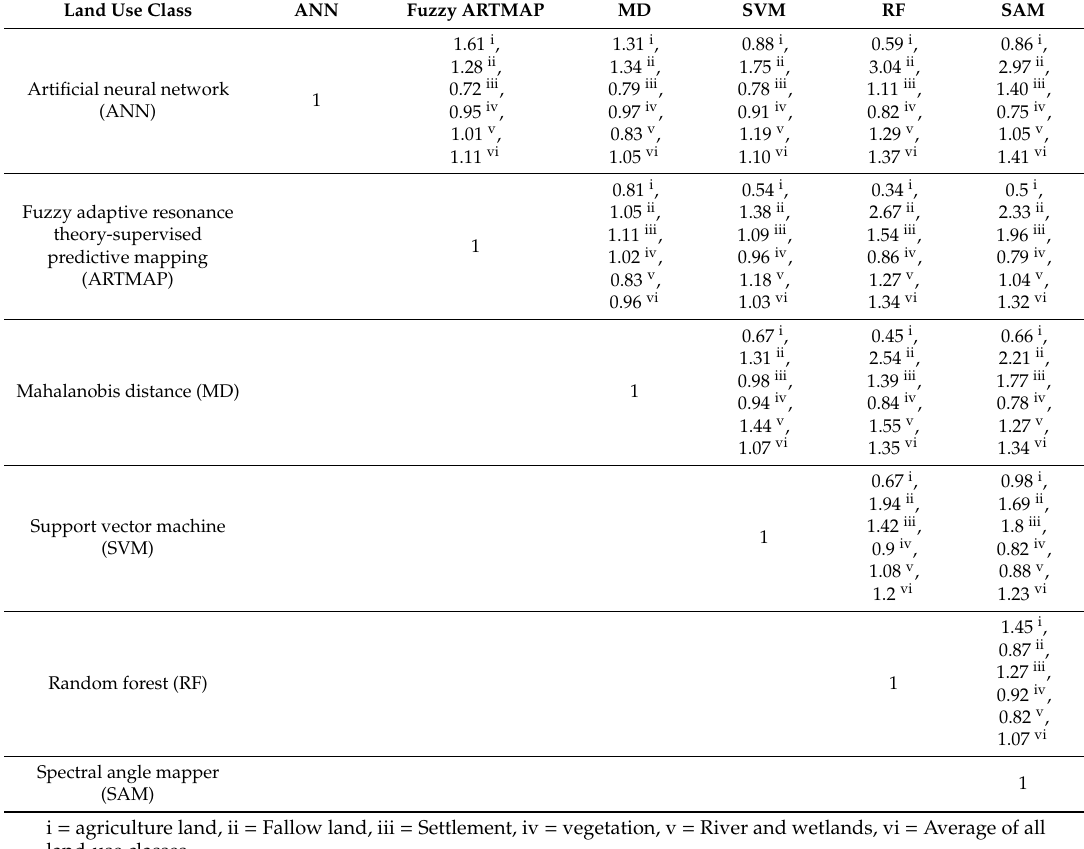
Table 4. Similarity ratio matrix of the proportion of LULC between two algorithms.